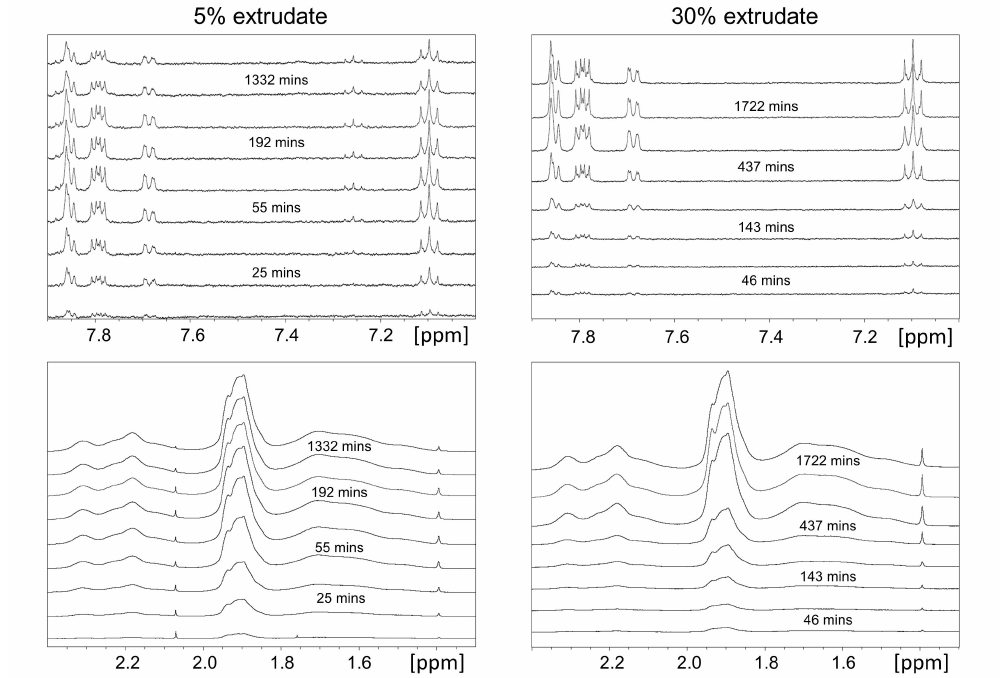
Figure 3. Portions of the 1 H-NMR spectra acquired during the dissolution of the 5% and 30% extrudates. Bicalutamide and coPVP data were obtained from single integrals at 7.06–7.14 ppm (two aromatic protons of fluorobenzene) and 1.2–2.6 ppm (protons of pyrrolidone ring and methylene chains)